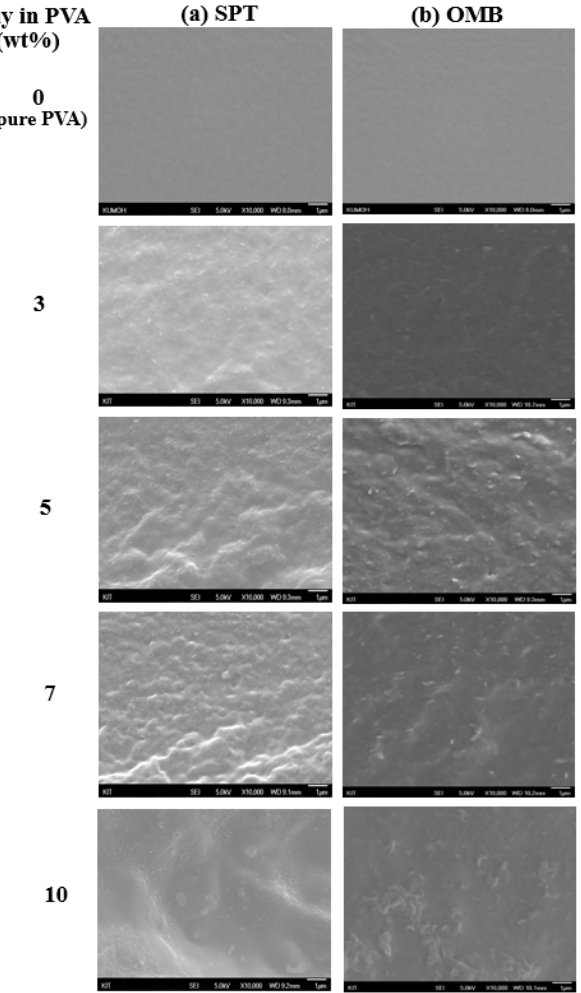
Figure 5. FE-SEM micrographs of PVA hybrid films with various clay contents: ( a ) SPT and ( b ) OMB in PVA (×10,000).